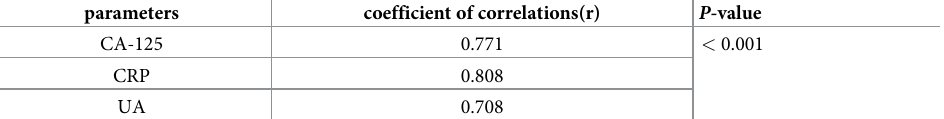
Table 3. Coefficient of correlations (r) of cancer antigen (CA-125), C-reactive protein (CRP) and uric acid (UA) with mean arterial blood pressure (MAP) in